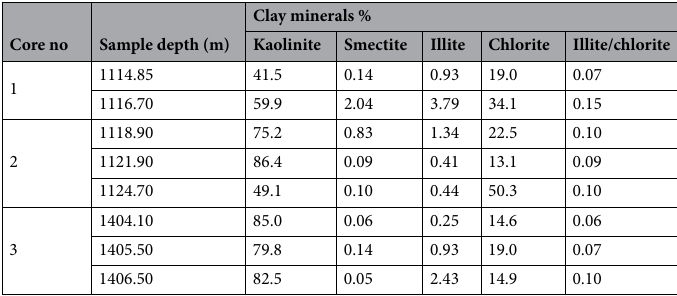
Table 7. Percentages of the clay minerals in the analyzed samples.